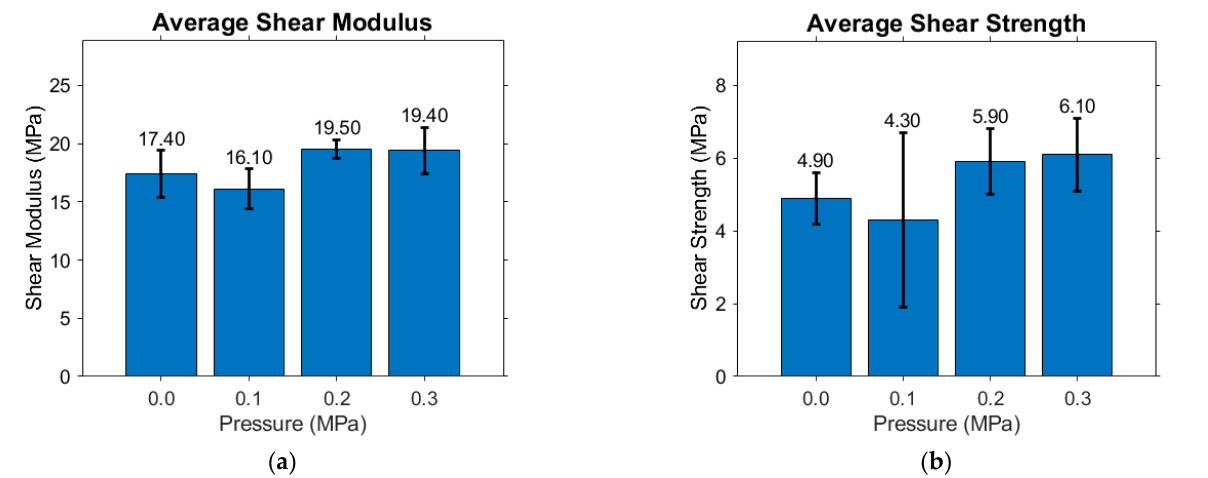
Figure 8. Specimens welded in pressure control with varying graphite coverage and resulting ( a ) average shear modulus and ( b ) shear strength.